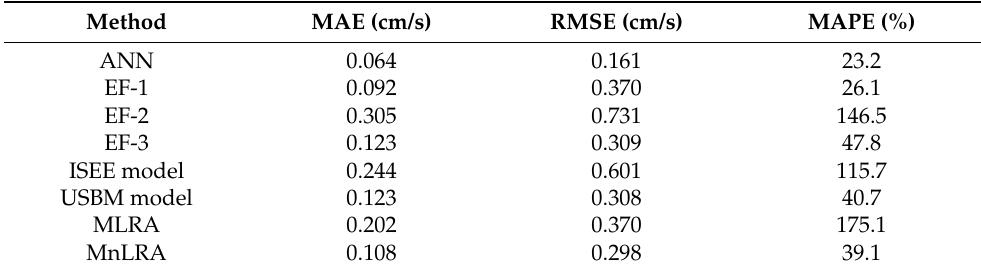
Table 7. Performances of the six prediction